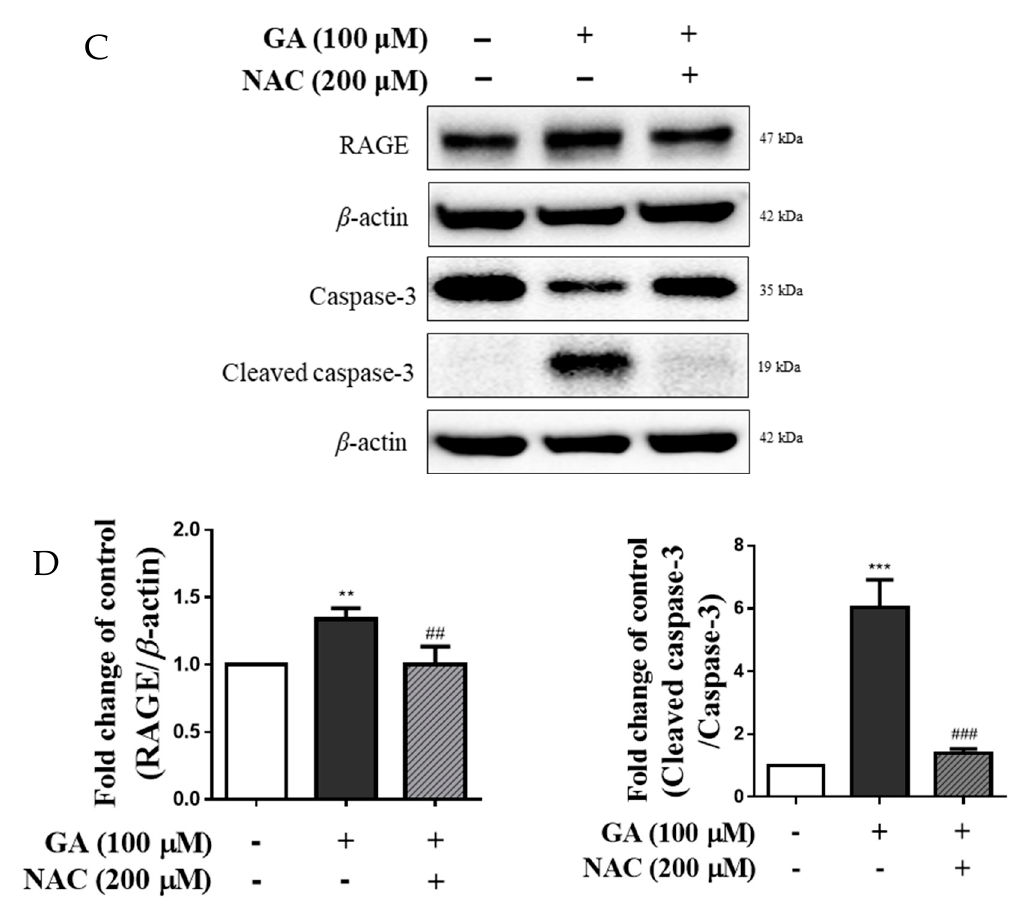
Figure 4. Changes in expression of RAGE apoptosis-related protein in mesangial cells by GA-induced oxidative stress. Mesangial cells were treated with sole GA (100 µ M), or GA (100 µ M) followed by cotreatment with AG (1 mM) or NAC (200 µ M) for 24 h. ( A ) Intracellular ROS production was evaluated using DCFH-DA dye, and cells were detected by fluorescence (scale bar = 50 µ m). ( B ) Quantification of intracellular ROS generation in mesangial cells. The control groups were analyzed using ImageJ software, and all data were normalized to control cells. ( C ) Protein expression of RAGE and caspase-3 was detected by Western blotting. ( D ) Quantification of RAGE and caspase-3 expression levels. β -actin was used as an internal control. Data were obtained from three independent experiments. Values are presented as the mean ± SD from three independent experiments. ** p <